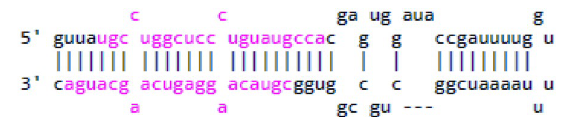
Fig. 6 MiRBase entry of miR-160c from Arabidopsis sp . In this entry, the two annotated sequences of miRNA and miRNA* do not follow the biogenesis rule of two hanging nucleotides, as there are three nucleotides left in each end. This type of entries could not be verified during the evaluation process because the algorithm works only with the normal two-nucleotide ends